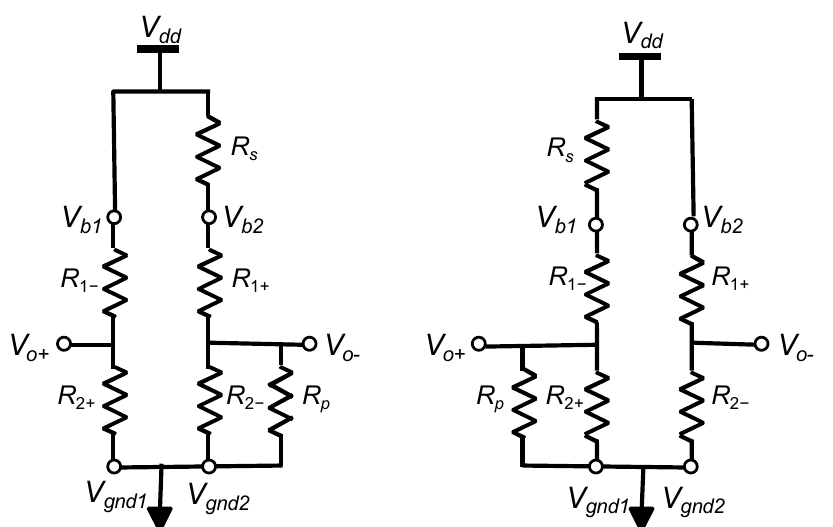
Figure 5. Offset and thermal drift of offset compensations for negative ( left ) and positive ( right ) post-manufacturing offset.